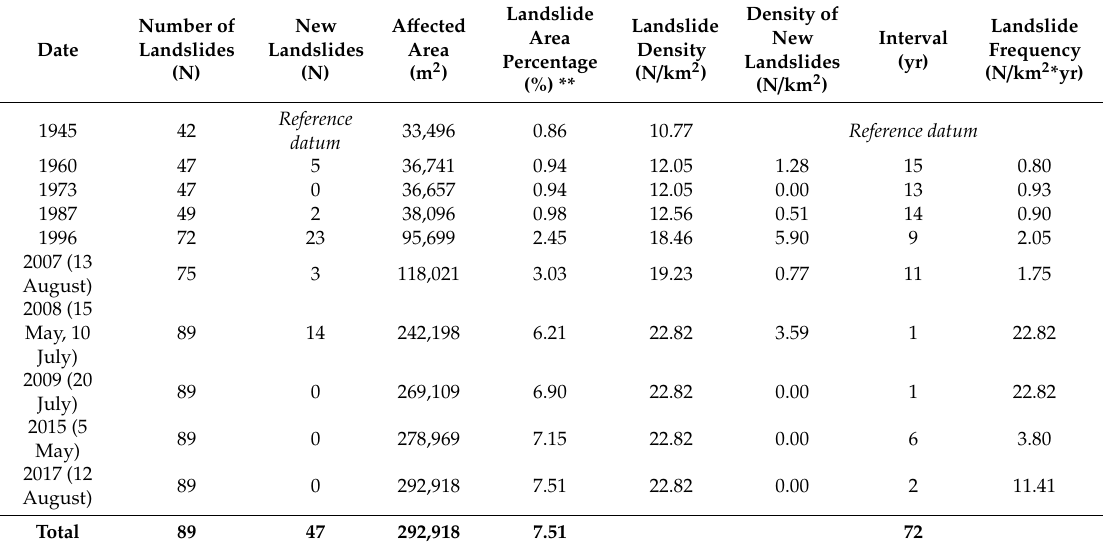
Table 2. Statistical parameters of the studied landslide sites on the west blu ff of Skolis Mountain.